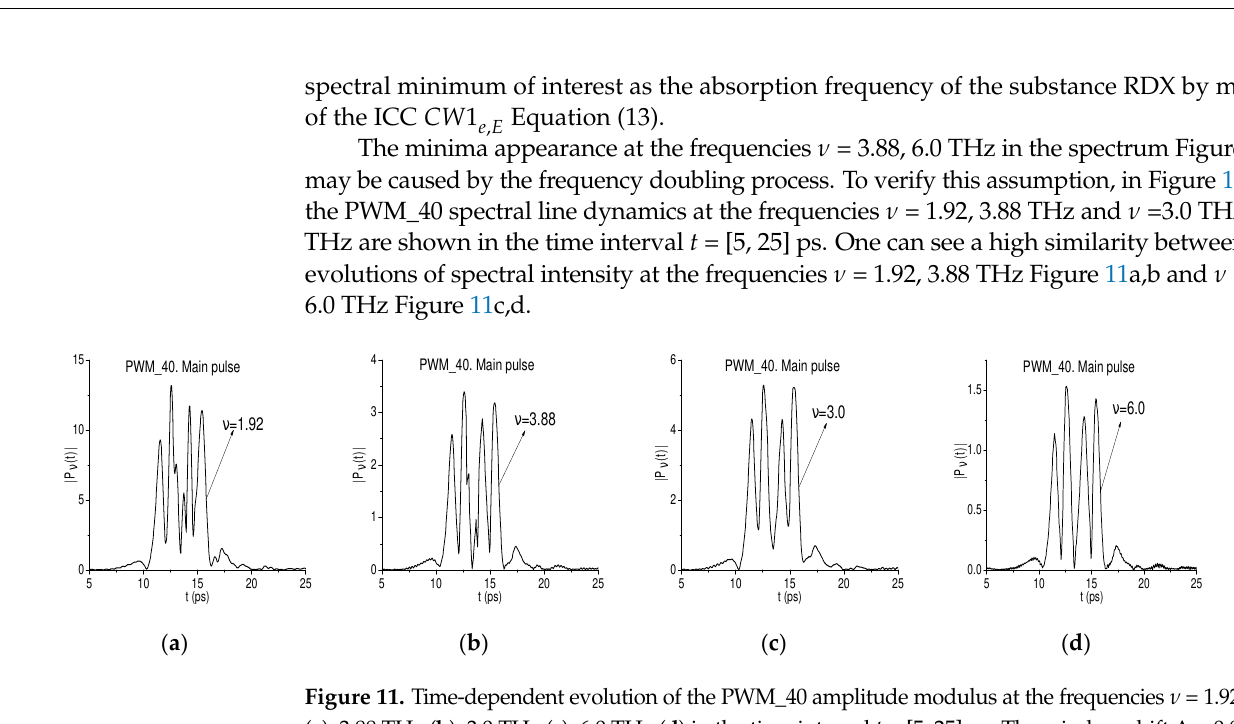
Figure 11. Time-dependent evolution of the PWM_40 amplitude modulus at the frequencies ν = 1.92 THz ( a ), 3.88 THz ( b ), 3.0 THz ( c ), 6.0 THz ( d ) in the time interval t = [5, 25] ps. The window shift Δ = 0.05. It should be stressed that the structure of the spectral dynamics depends on the size of the time window T and its shift ∆ . If the dynamics’ structure is complex, it is necessary to change these parameters in order to reveal characteristic features of the dynamics. In this case, (Figure 11), we reduced the window shift from ∆ = 0.2 ps up to ∆ = 0.05 ps. This allowed us to detect the difference in the shapes of the dynamics. One can see that the spectral dynamics at the frequencies ν = 1.92, 3.88 THz in Figure 11a,b differ from those in Figure 11c,d—they have two additional maxima in the time interval t = [12.5, 14.6] ps. Moreover, the generation of the doubled absorption frequencies occurs in other time intervals. This is easily seen in Figure 12a, in which the correlation coefficient c e , E ( t n ) between the long PWM_40 spectral line dynamics at the frequency ν = 1.92 THz and the short spectral line dynamics, computed for the PWM_40 main pulse at the doubled frequency ν = 3.88 THz, is depicted (we will denote this frequency pair as ν = (1.92, 3.88). THz). To obtain the correlation coefficient c e , E ( t n ) , we shift the short spectral line dynamics at the doubled frequency ν = 3.88 THz along the spectral line dynamics computed in the long time interval t = [0, 180] ps at the basic frequency ν = 1.92 THz. In Figure 12b, a similar computation is shown for the frequency pair ν = (3.0, 6.0) THz. One can see in Figure 12a,b that the pronounced maxima of the correlation coefficients (0.986 and 0.99, respectively) are achieved in the time interval t = [0, 20] ps, corresponding to the main pulse of the reflected THz signal PWM_40.